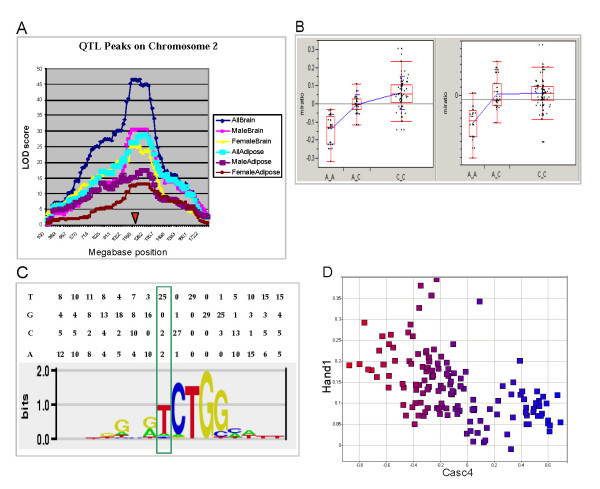
An example of a putative candidate cis-regulatory SNP affecting transcription in mouse F2 population. A. cis-acting LOD scores for Casc4 on chromosome 2 in multiple tissues and sample sets (male, female or combined/all) in the BXH cross. x-axis – genomic location in Mb, y-axis – LOD score from interval mapping. Physical location of the gene is indicated with a red arrow-head. Only LODs scores >10 are shown. B. Association of expression levels of Casc4 with genotypes of the promoter SNP, mCV23866990. The distribution of the expression levels in brain (left) and adipose (right) is shown according to the genotypes of this SNP in the F2 animals. A_A represents the DBA and C3H allele, and C_C the B6 allele. C. A binding site for transcription factor Hand1 is affected by SNP mCV23866990. The polymorphism changes a highly conserved base in the binding site (T→C change on the reverse strand, boxed and shaded). The frequency matrix and a sequence logo of the profile representing the binding site are shown. D. Scatter plot of Casc4 (x-axis) versus Hand1 expression levels in the body atlas data set [49, 50]. Hand1 expression is correlated to that of Casc4 with a p-value of < 10-6 (Spearman rank order correlation -0.58).